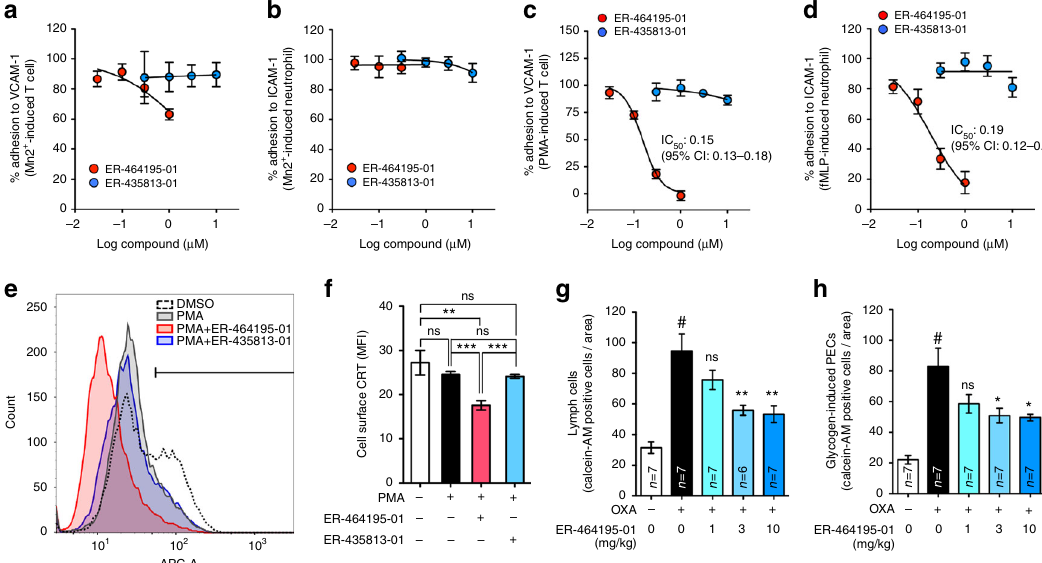
Fig. 2 ER-464195-01 suppresses the cell adhesion and the migration of leukocytes. a , b Inhibition of MnCl 2 -induced T cells and neutrophils adhere to VCAM-1 a and ICAM-1 b , respectively, by ER-464195-01 or ER-435813-01. Results are given as the mean ± SEM of n = 3 independent experiments performed in duplicate. c , d IC 50 values for inhibition of PMA-induced T cells and fMLP-induced neutrophils adhere to VCAM-1 c and ICAM-1 d , respectively, by ER-464195-01 or ER-435813-01. Results are given as the mean ± SEM of n = 3 independent experiments performed in duplicate. e , Flow cytometric analysis for the cell surface CRT in PMA-stimulated Jurkat cells with ER-464195-01 or ER-435813-01. f , Quantitative analysis of e . Results are given as mean ± SEM of n = 6 experiments; * P < 0.05, ** P < 0.01 and ns (not signi fi cant). Statistical signi fi cance was evaluated using one-way ANOVA with Bonferroni ’ s multiple comparison test. MFI, mean fl uorescence intensity. g , h In vivo ef fi cacy of ER-464195-01 on OXA-induced lymph cells g and glycogen-induced PECs h in fi ltration into OXA-treated colons. Results are given as the mean ± SEM of n = 6 or 7; # P < 0.0001, OXA group versus control (without the injection of OXA emulsion) (two-tailed t test). * P < 0.05, ** P < 0.01, *** P < 0.001 and ns, OXA with ER-464195-01 groups versus OXA